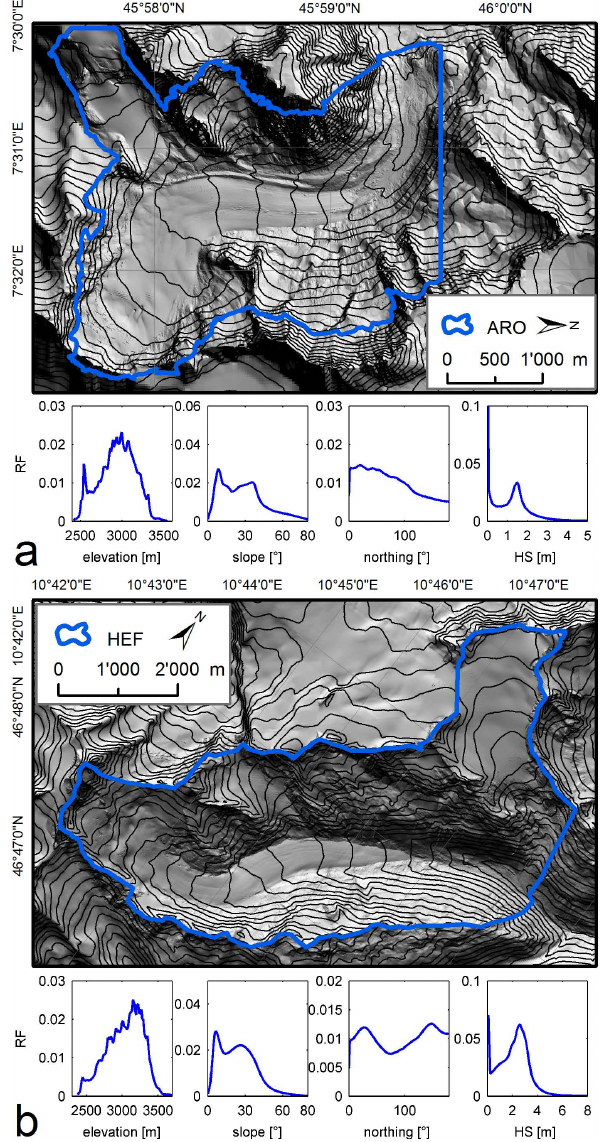
Fig. 2. Hillshade map of (a) Haut Glacier d’Arolla (ARO) and (b) the Hintereisferner (HEF) study areas. The contour lines have an equidistance of 50m. The right panels show histograms for el- evation, slope, northing and the area-wide absolute snow depth obtained from ALS (for HEF: Mai 2002). Data source basemap: